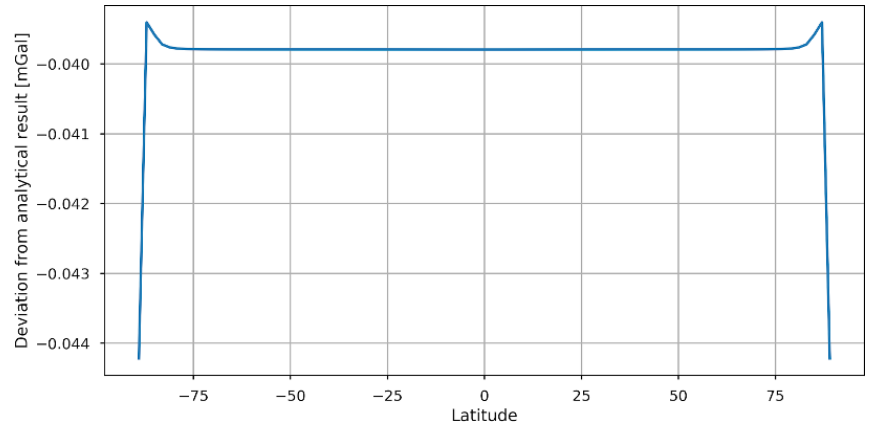
Figure 4. Deviation of the tesseroid integration from the analytical shell result as a function of latitude. This is for the case of the 2km thick shell with a 1 ◦ lateral resolution. Table 1. Summary of the homogeneous density shell test at the target height h = 6371 + 250 = 6621km with G = 6 . 67428 × 10 − 11 m 3 kg − 1 s − 2 . The numbers indicate average residuals and their maximum variation. Note that ASPECT uses by default G